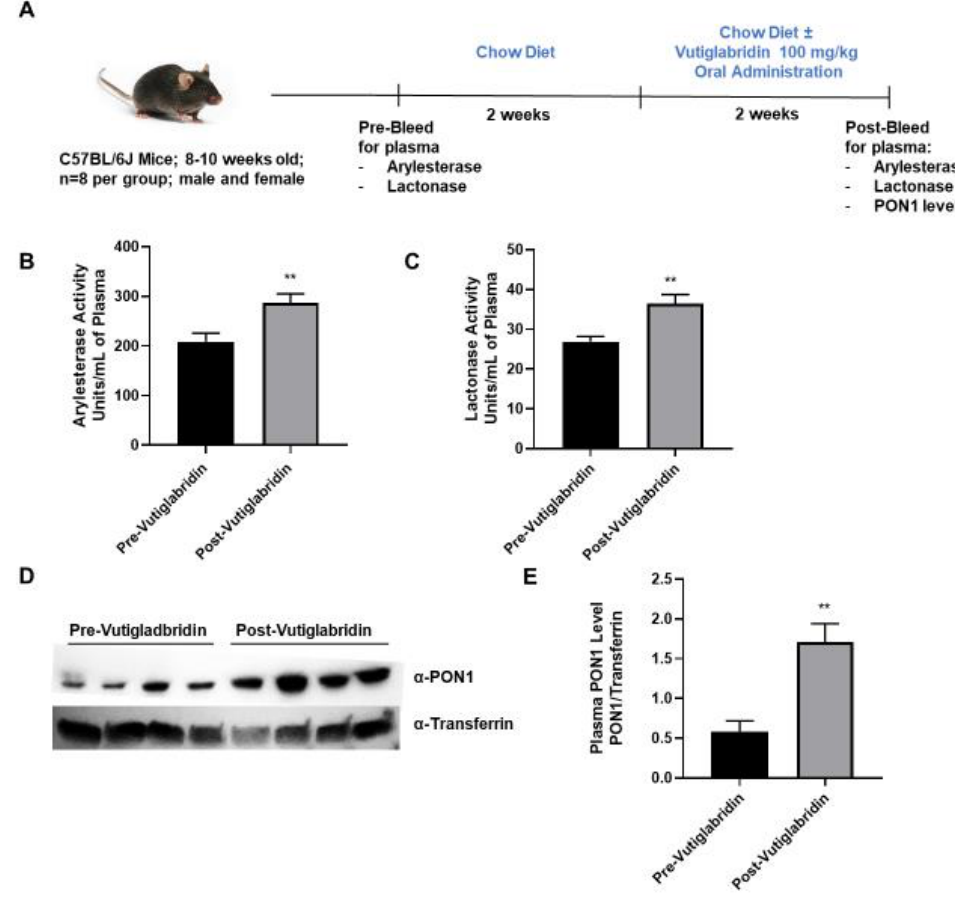
Figure 3. Role of vutiglabridin in modulating expression and activity of PON1. ( A ) Male and female WT, C57BL/6J mice between 8 − 10 weeks of age were pre-bled for plasma collection and were fed a chow diet for two weeks, followed by vutiglabridin at a dose of 100 mg/kg in their chow diet for another two weeks ( n = 7–8/group), at which point the post-bleeding plasma collection occurred. Arylesterase ( B ) and lactonase ( C ) assays were performed on the plasma collected from the mice for comparison of pre- vs. post-vutiglabridin treatment ( D ). PON1 expression ( n = 4/group) was evaluated in the plasma of male, WT mice via Western blot analysis, normalized to transferrin, and quantified as a ratio of PON1 to transferrin ( E ). The data are represented as mean ± SEM. Student’s t -test was performed. Statistically significant data are noted as ** p < 0.01.